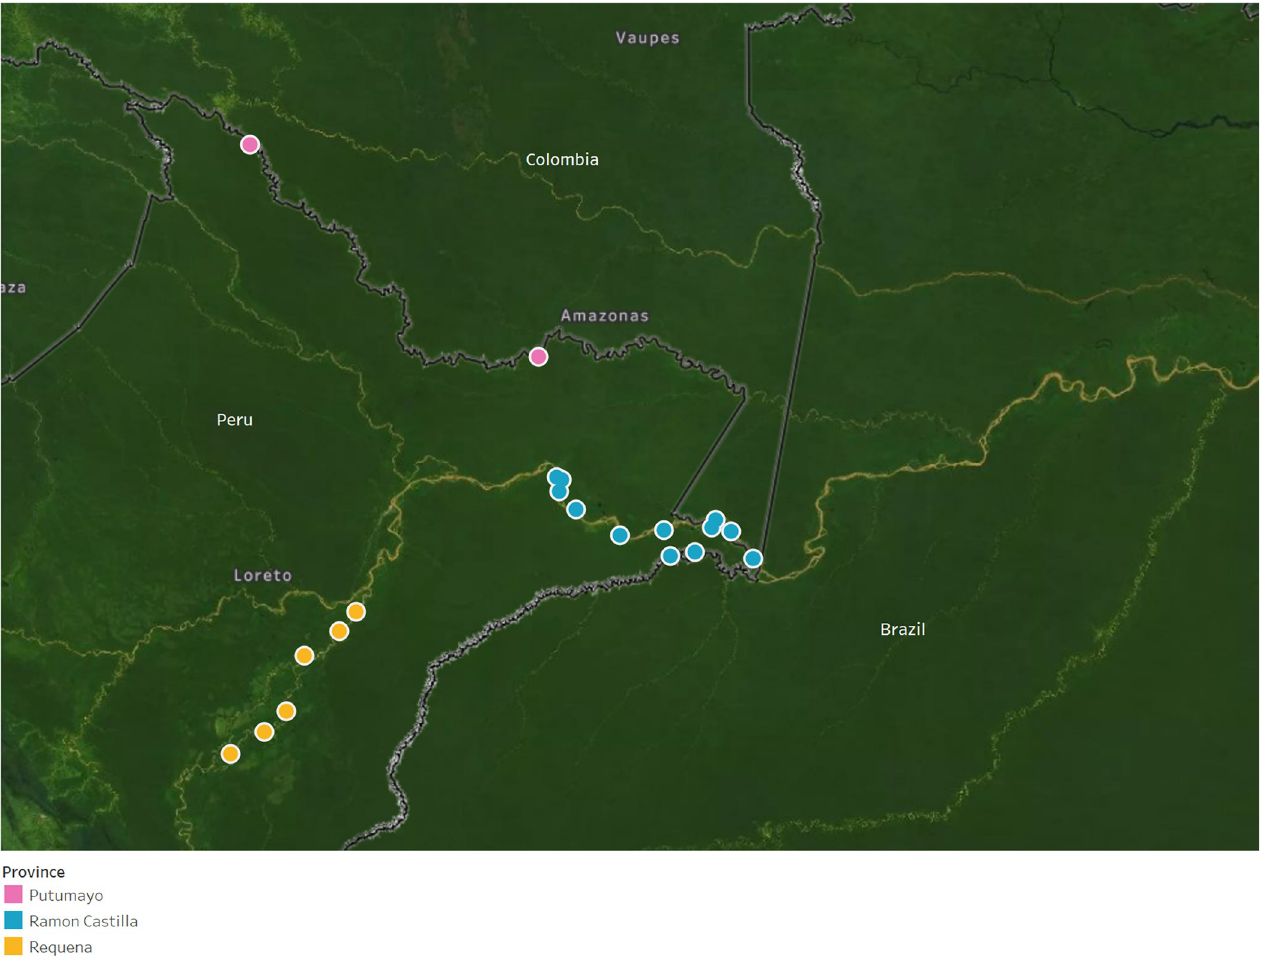
Fig 1. Clusters included in the study area by province in rural communities of Loreto Department, Peru 2017. (Figure created using Tableau Desktop (Seattle, USA) using a base map licensed under the Open Data Commons Open Database License by the Open Street Map Foundation).